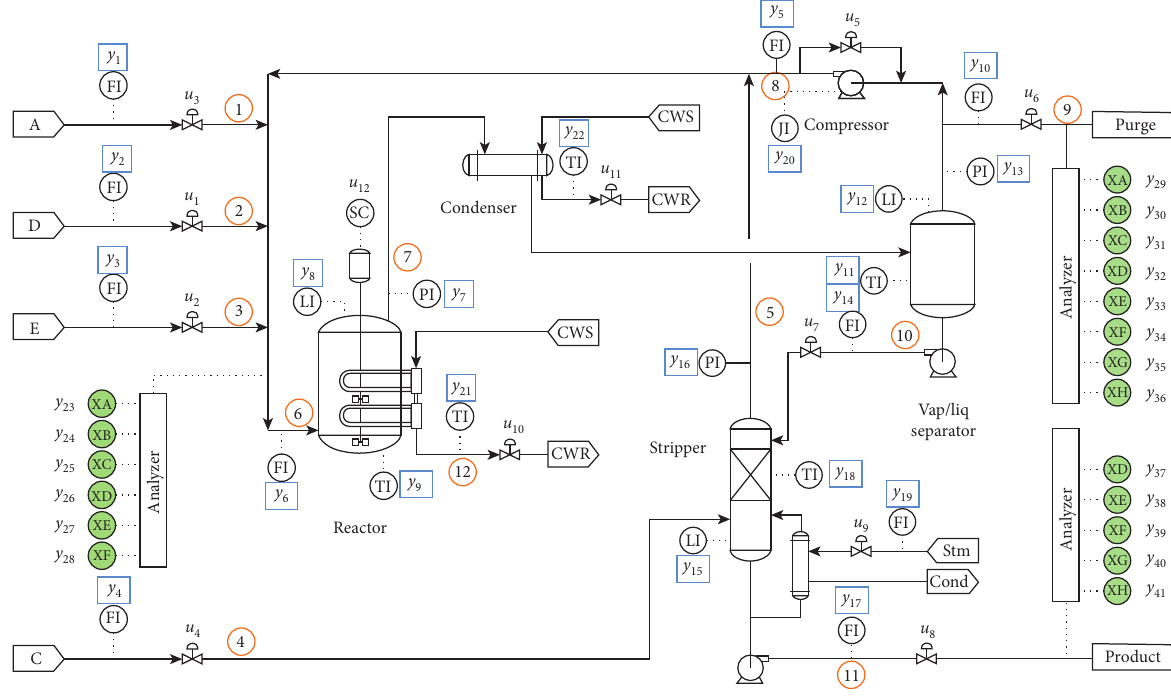
Figure 1: Tennessee Eastman process flowchart.